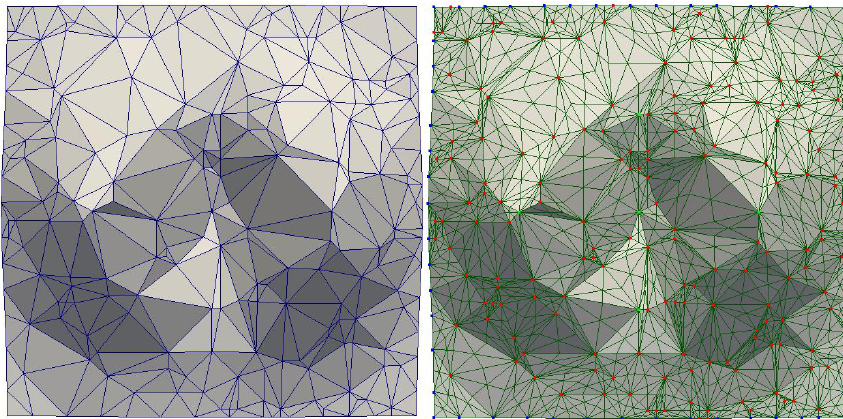
Figure 2. Initial TIN surface (left) and its dual grid TD (right). The initial sample points on the dual grid are also